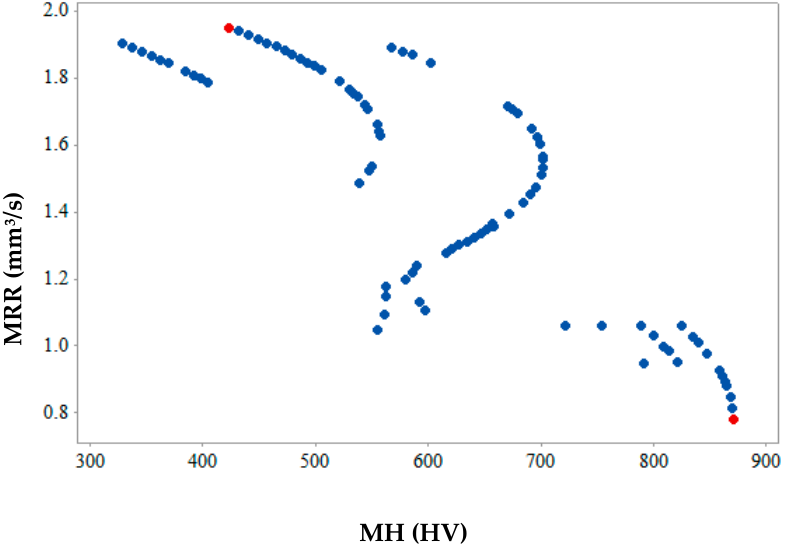
Figure 13. 2-D Pareto optimal points for MRR vs. MH.